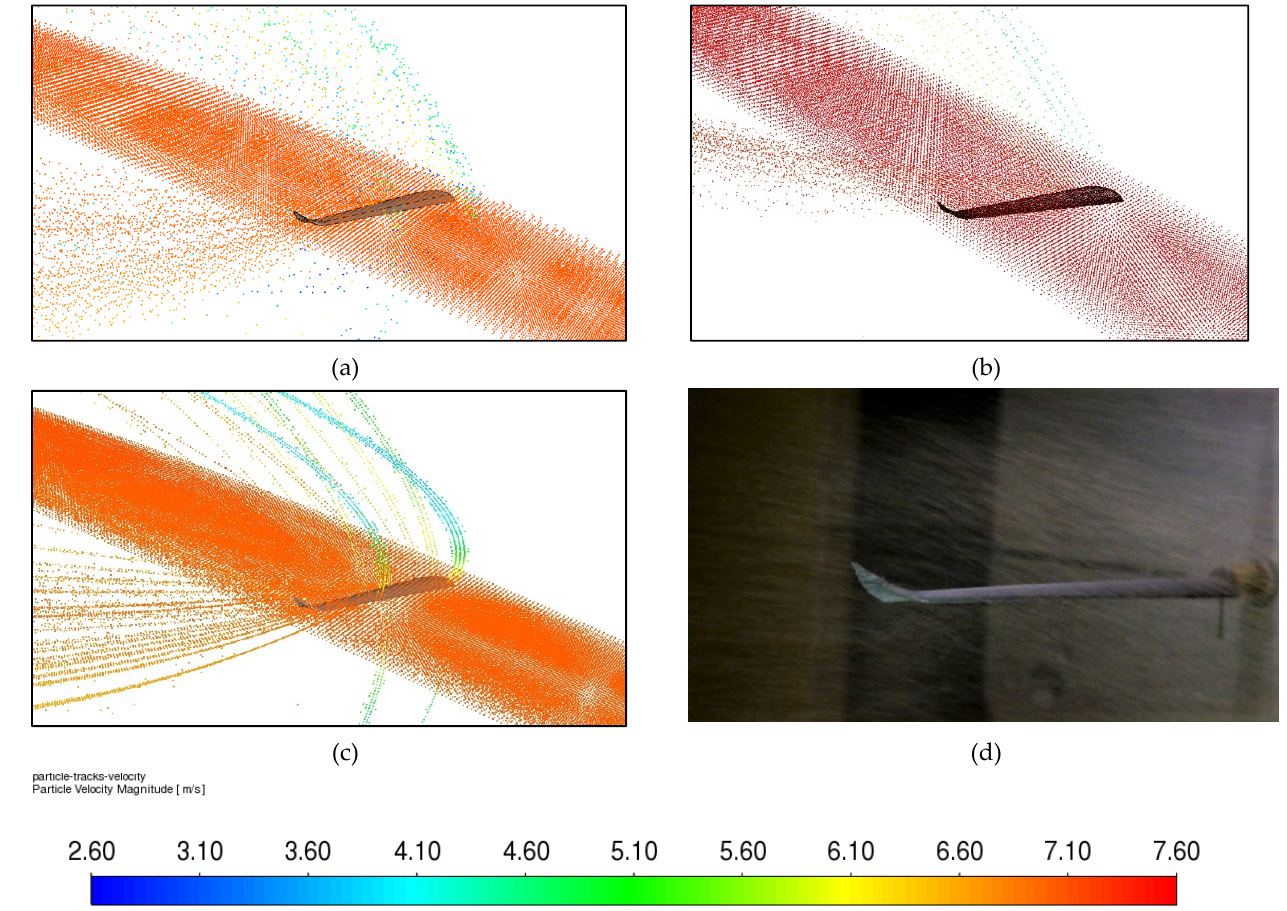
Figure 19. Solid particles’ trajectories and velocity magnitude in two-phase flow (air–sand) in ( a ) mosaic poly-hexcore mesh ( b ) unstructured mesh ( c ) structured mesh ( d ) subsonic wind tunnel.